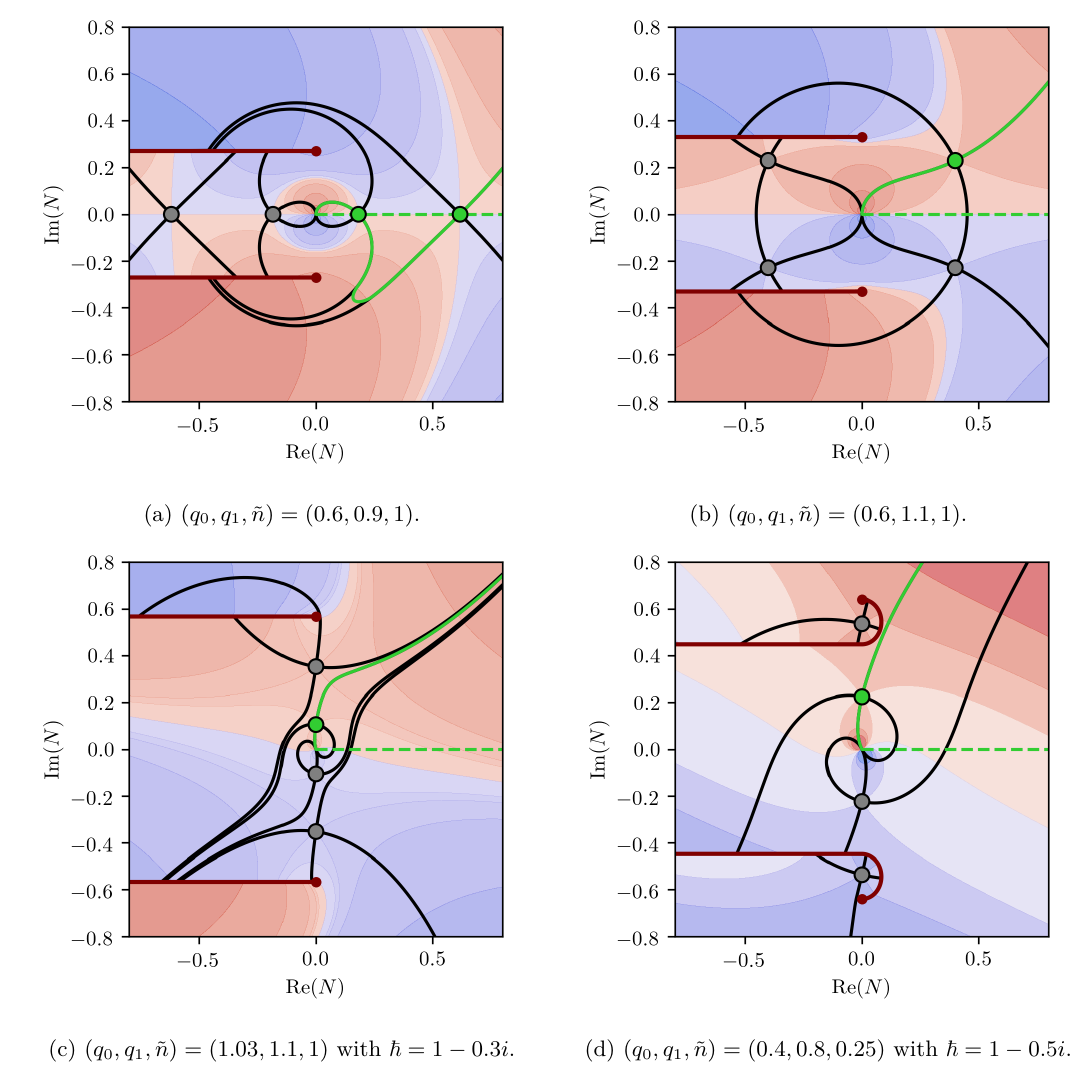
Figure 1. Structure of iS [ N, q + , n ] in the complex- N plane for (a) q 0 , q 1 < ˜ n , (b) q 0 < ˜ n < q 1 , (c) q 0 , q 1 > ˜ n with 1 + 1 > 1 and (d) q 0 , q 1 > ˜ n with 1 + 1 < 1 . In (c) and (d) we have set q 0 q 1 ˜ n q 0 q 1 ˜ n Im( ~ ) < 0 to resolve ambiguities in the Picard-Lefschetz prescription as described in the main text. Regions of red have Re( iS ) < 0 and regions of blue have Re( iS ) > 0 : several level-sets of Re( iS ) are shown with dotted lines. Steepest ascent/descent contours (level-sets of Im( iS ) emanating from the saddle points) are shown with solid black lines. The initial and deformed N -contours are shown with dashed and solid green lines,